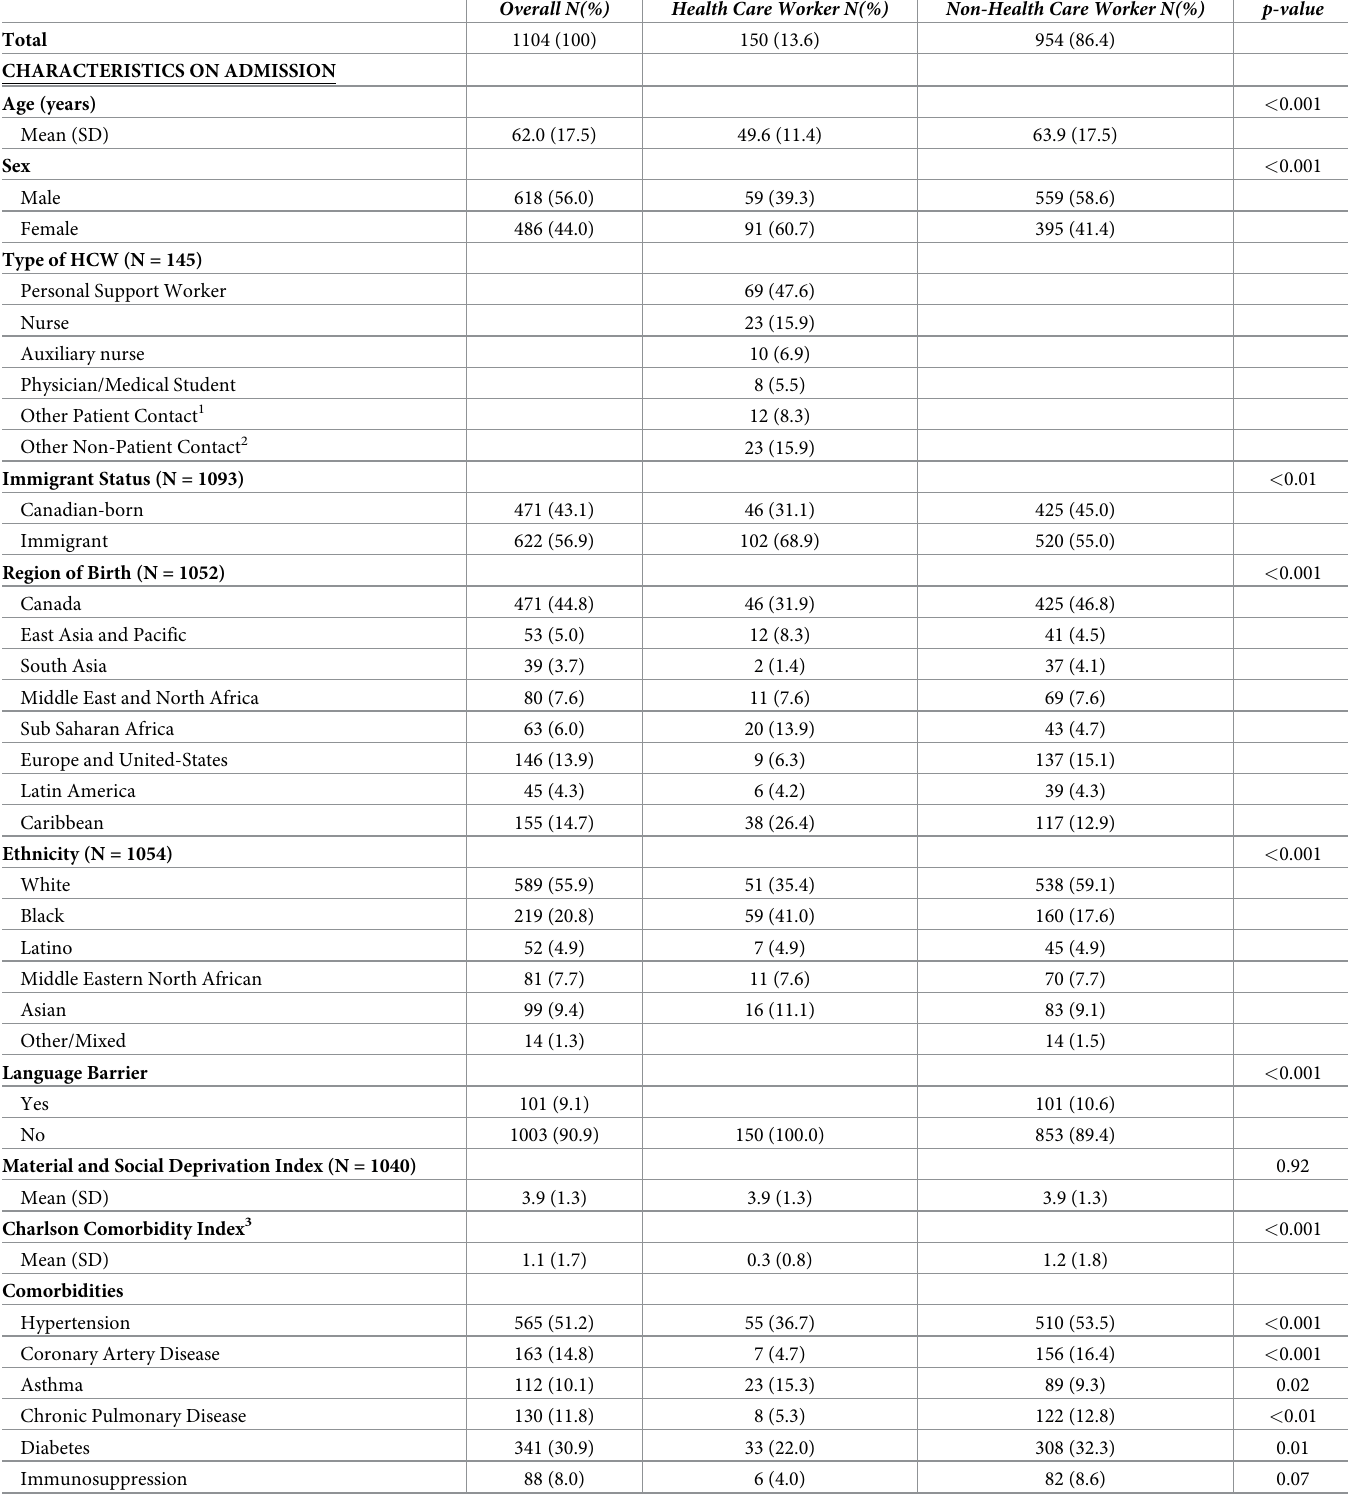
Table 1. Chart review data stratified by healthcare worker vs. non–healthcare